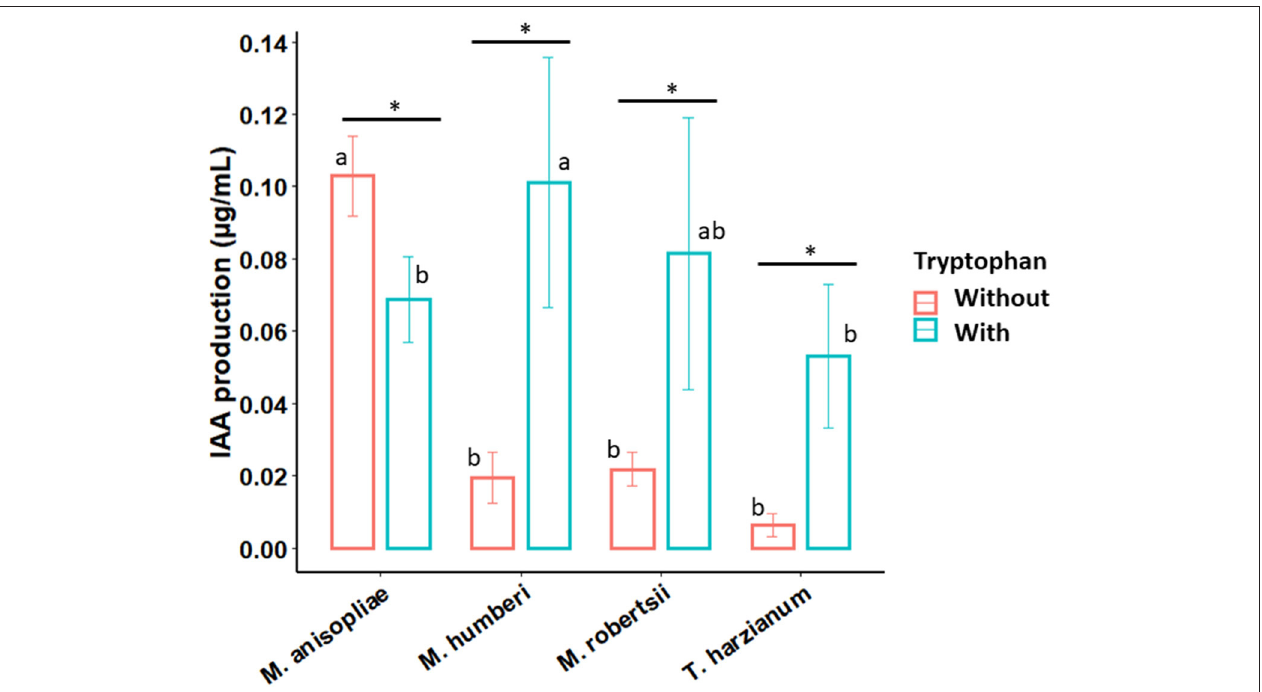
FIGURE 5 | Effect of phenotype and exogenous tryptophan on the ability of Metarhizium species to produce indole-3-acetic acid (IAA) under in vitro conditions. Trichoderma harzianum was used as a positive control for IAA production. Bars (means ± 95% CIs [confidence intervals]) followed by distinct lowercase letters denote significant differences between fungal species for each culture medium (with or without tryptophan), while asterisk (*) indicates significant differences between culture medium supplemented with or without tryptophan within each fungal species. Statistical contrasts were performed with Tukey HSD method at P < 0.05 ( n =